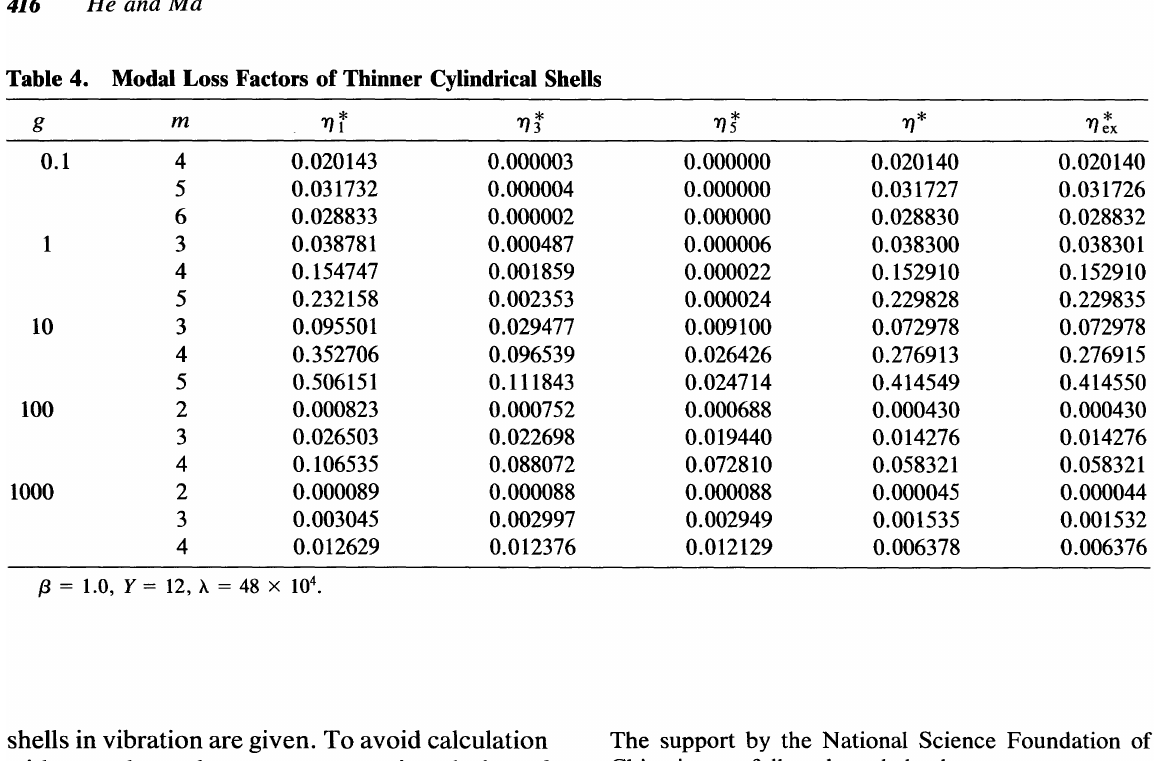
Table 4. Modal Loss Factors of Thinner Cylindrical